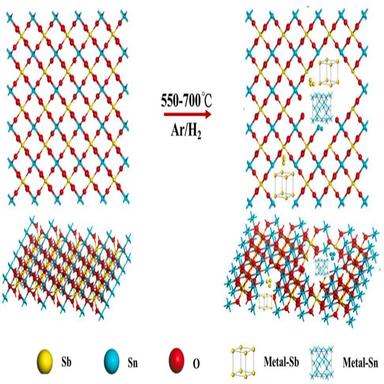
Atomic diagram of SSO crystal structure change during Sb and Sn in-situ precipitation.